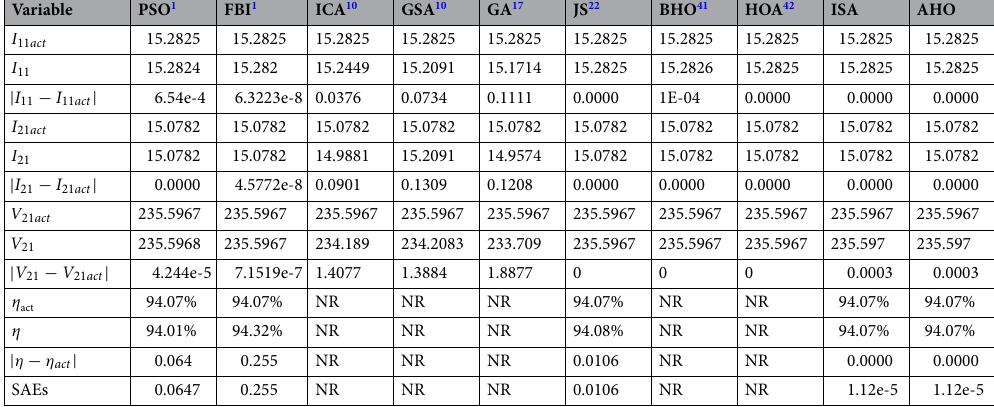
Table 4. Comparisons between errors of the AHO and other optimizers for 4 kVA transformer at Full load. NR not reported.